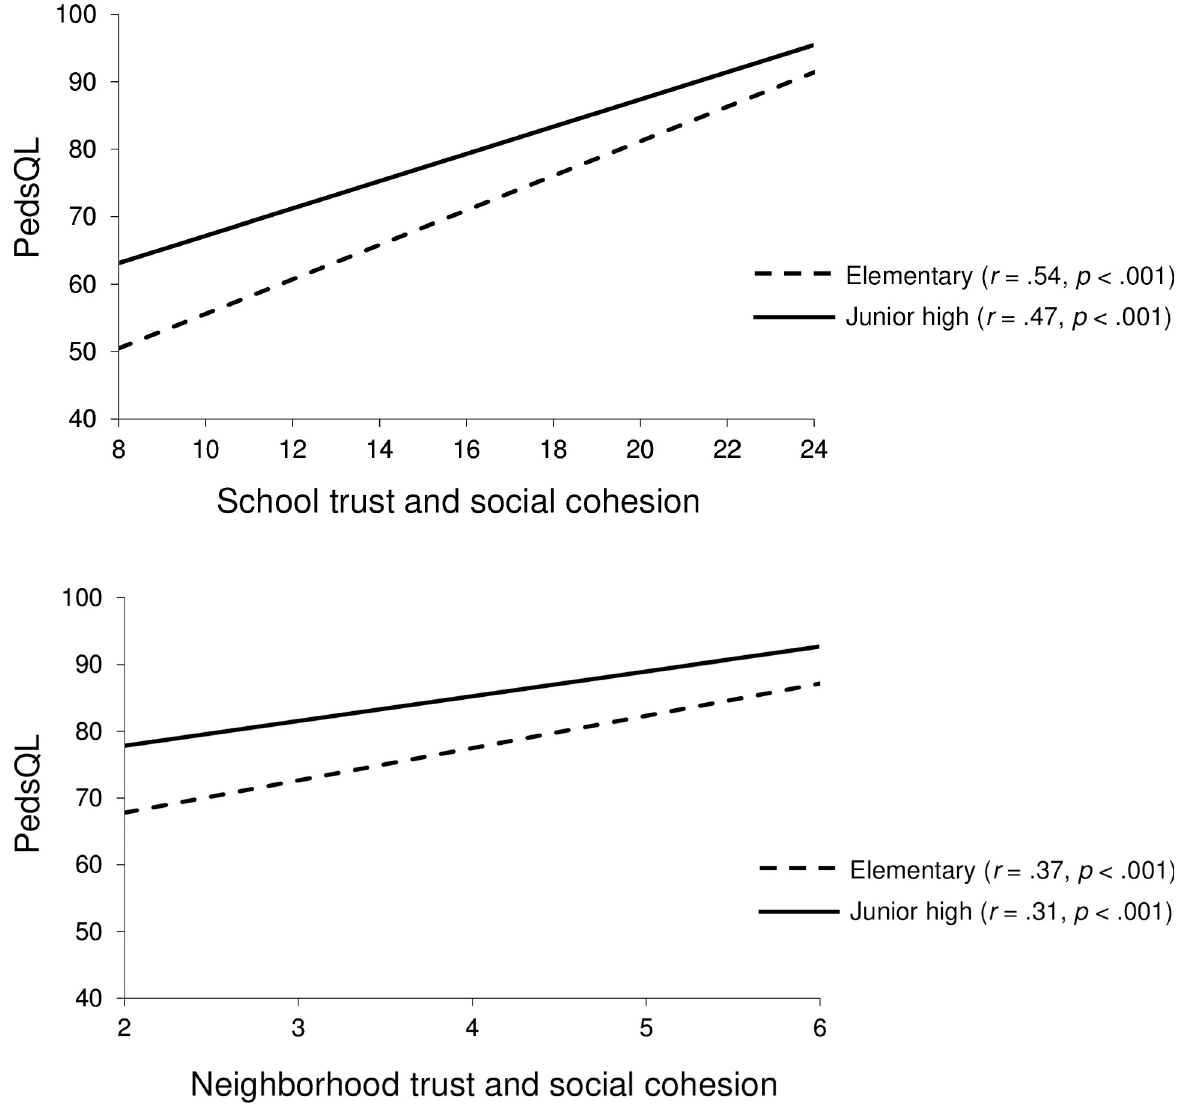
Fig 3. Interaction between social capital and educational stage on QoL. (a) Plots of the impacts of the interaction between “school trust and social cohesion” and educational stage on QoL. (b) Plots of the impacts of the interaction between “neighborhood trust and social cohesion” and educational stage on